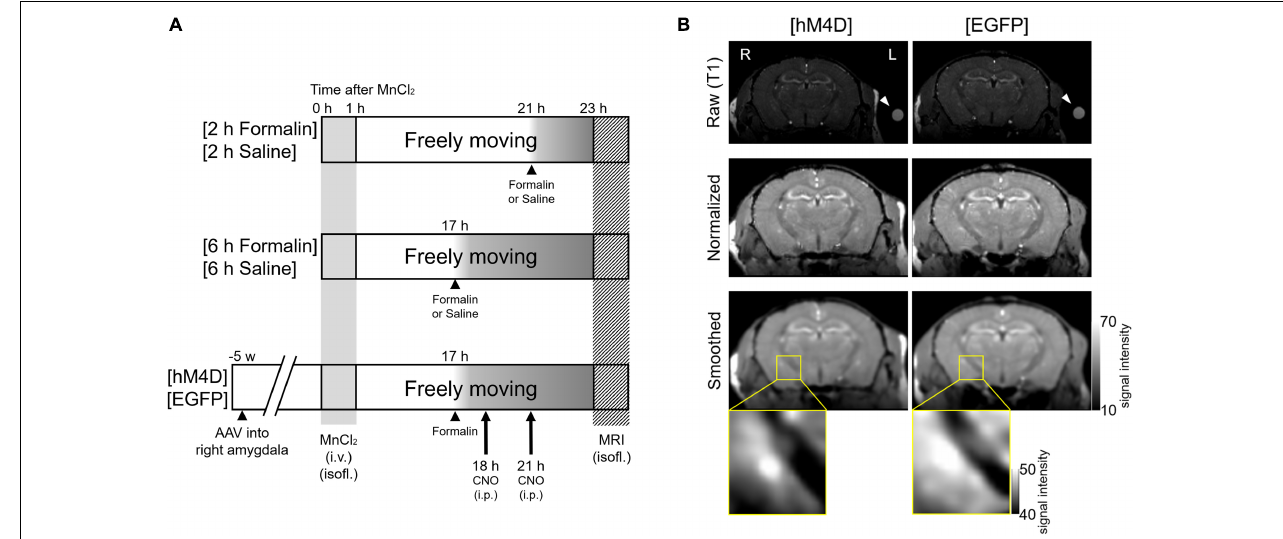
FIGURE 1 | Experimental procedures and visualization of the DREADD effect. (A) Mice were divided into three cohorts with two groups each. In the first cohort (Top), formalin or saline was injected 2 h before scanning into two groups of mice, termed [2 h Formalin] ( n = 8) and [2 h Saline] ( n = 6), respectively. In the second cohort (Middle), formalin or saline was injected 6 h before scanning, termed [6 h Formalin] ( n = 7) and [6 h Saline] ( n = 7), respectively. In the third cohort (Bottom), microinjection of either AAV5-hSyn-HA-hM4D(G i )-mCherry or AAV5-hSyn-EGFP into the right amygdala was performed 5 weeks before scanning. These groups were termed [hM4D] ( n = 6) and [EGFP] ( n = 6), respectively. Formalin was injected 6 h before scanning and clozapine N-oxide (CNO) was intraperitoneally injected twice at 1 h and 4 h post-formalin. MnCl 2 solution was injected into all cohorts of mice 23 h before scanning. (B) Top, representative coronal T1-weighted raw images of [hM4D] (left) and [EGFP] (right) mouse brains are shown. R, the right side of the mouse; L, the left side. A silicon reference tube filled with 0.1 mM MnCl 2 solution was attached to the left temporal head of the mouse (arrowhead). Middle, normalized images after registration. Bottom, smoothed images. The statistical analyses described in the text were conducted by using these smoothed images from each mouse. The magnified images on the bottom indicate the signal from the area containing the right amygdala from a mouse from the [EGFP] group and another from the [hM4D] group. Note that the signal is weaker in the central and basolateral amygdala in a [hM4D]